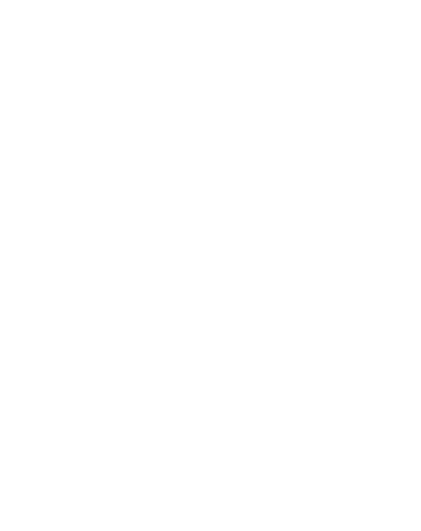
Table 2. Demographic details of